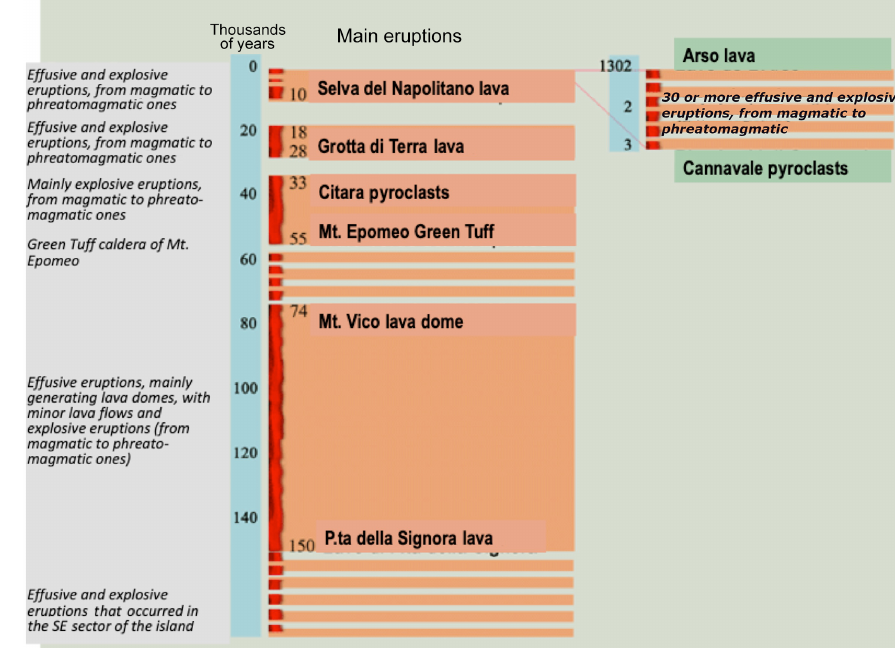
Figure 8. Eruptive history of the island of